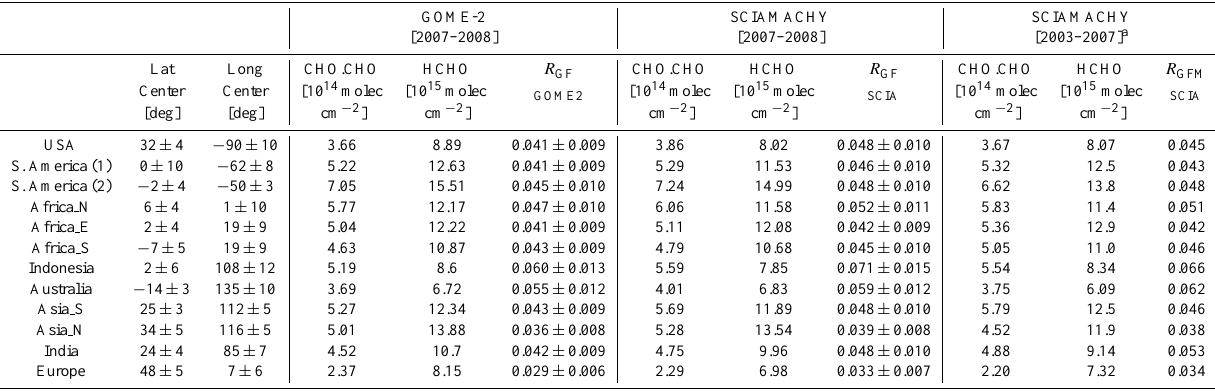
Table 2. Median values of the GOME-2 and SCIAMACHY column amounts of glyoxal and formaldehyde coupled with their average ratio, R GF . The GOME-2 and SCIAMACHY R GF 2007–2008 over 12 selected regions are compared to the median SCIAMACHY R GFM data of the period 2003–2007 which were presented to Vrekoussis et al. (2009). Data gridded to 0.5 ◦ × 0 . 5 ◦ have been used for the following